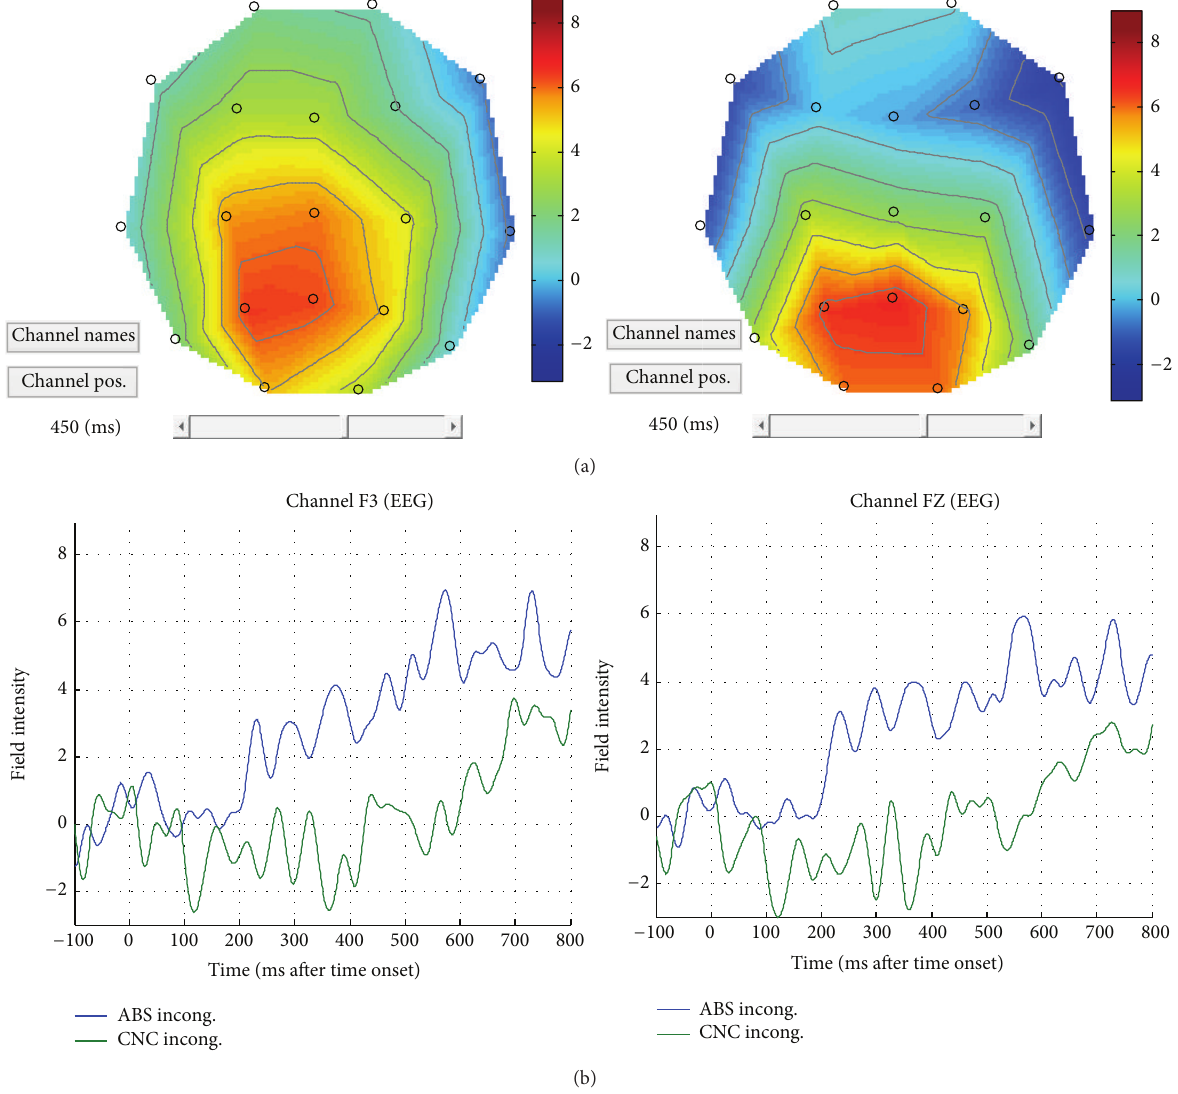
Figure 6: (a) Pattern of brain activity for abstract-incongruent and concrete-incongruent combinations. (b) ERP responses to abstract- incongruent (blue line) and concrete-incongruent (green line) objects for the control group, on left and central sites.